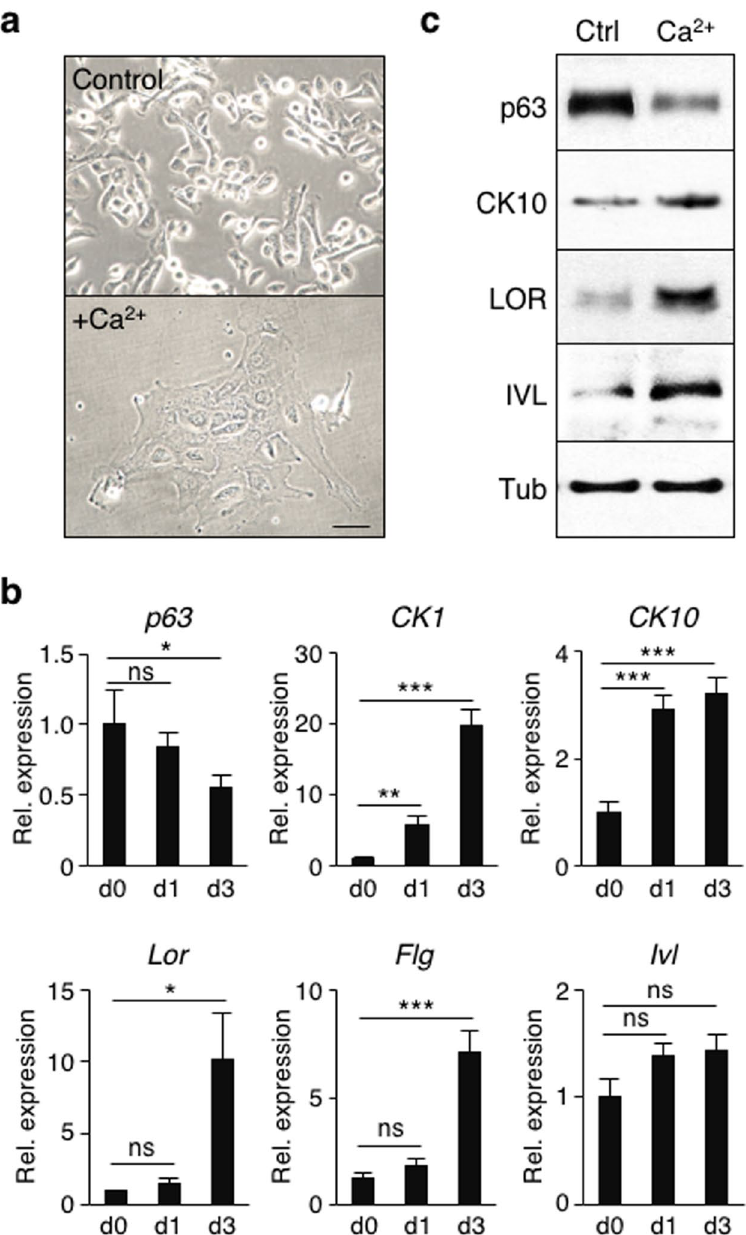
Figure 3. Mouse epidermal progenitor cells expanded by TGF- β inhibition are capable of differentiation in response to Ca 2 + stimulation in vitro . ( a ) Representative images of newborn mouse-derived, RepSox-expanded P18 epidermal cells before (upper) and after (lower) treatment with 0.3 mM Ca 2 + for 3 days. Bar = 25 μ m. ( b ) Quantitative RT-PCR analysis of epidermal cell differentiation marker genes. Newborn mouse-derived, RepSox-expanded P17 epidermal cells were induced to differentiate by treatment with 0.3 mM Ca 2 + (for CK1 , CK10 , Lor , Flg , and Ivl ) or 1.3 mM Ca 2 + (for p63 ) for 0–3 days as indicated. Data shown are normalized to the housekeeping gene Gapdh and expressed as mean ± s.e.m. (n = 3). * P < 0.05; ** P < 0.01; *** P < 0.005; ns , not significant. ( c ) Western blot analysis using antibodies against p63, CK10, loricrin (LOR), and involucrin (IVL). Newborn mouse-derived, RepSox-expanded P17 epidermal cells were induced to differentiate by the treatment with 0.3 mM Ca 2 + for 0 (Ctrl) and 3 (Ca 2 + ) days. Tubulin- α (Tub) was used as a loading control. The full-length blots are included in Supplementary Figure